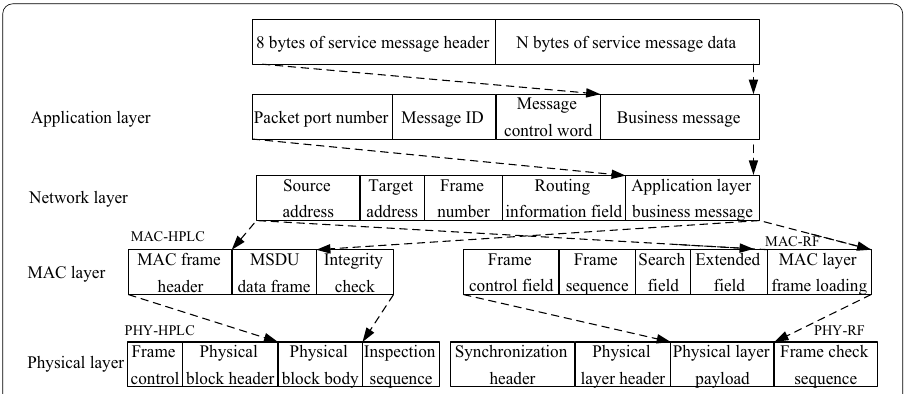
Fig. 4 The message frame encapsulation process of dual-mode communication